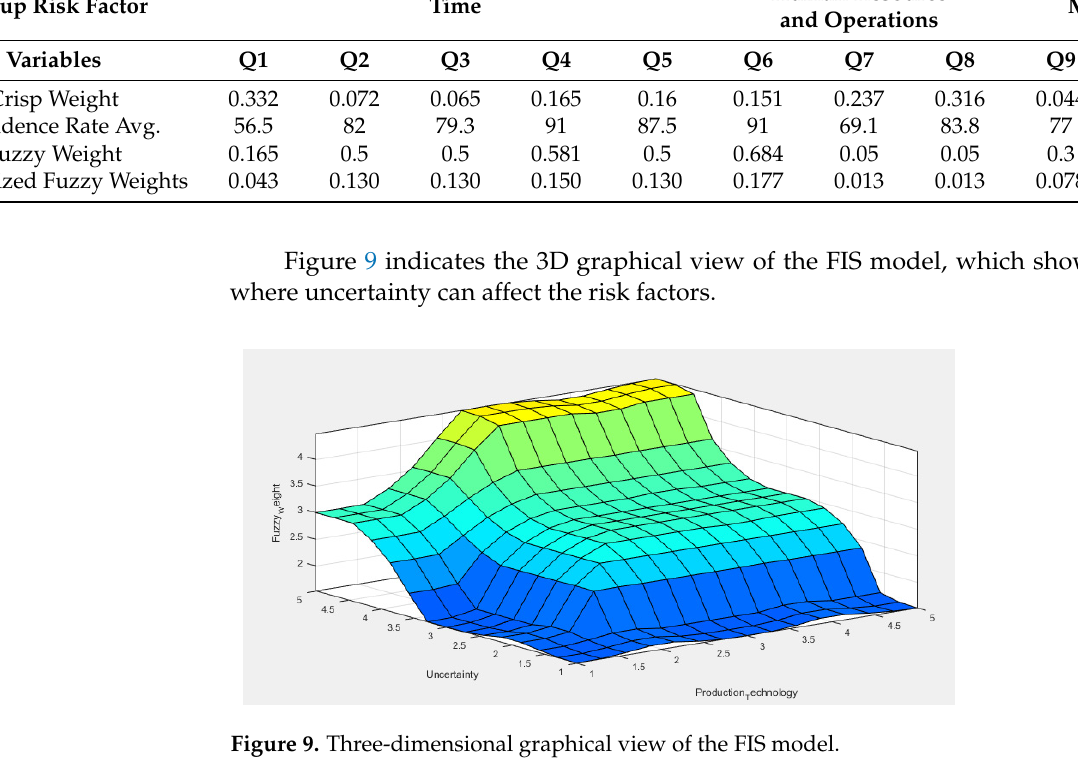
Figure 8. Fuzzy weights output window. The fuzzy weights can be calculated using Matlab’s fuzzy weights output window. Table 5 indicates the results of the fuzzy weights. The weights are then normalized to be applied to the mathematical model in the next section. Table 5. Normalized fuzzy weights. Table 5. Normalized fuzzy weights.